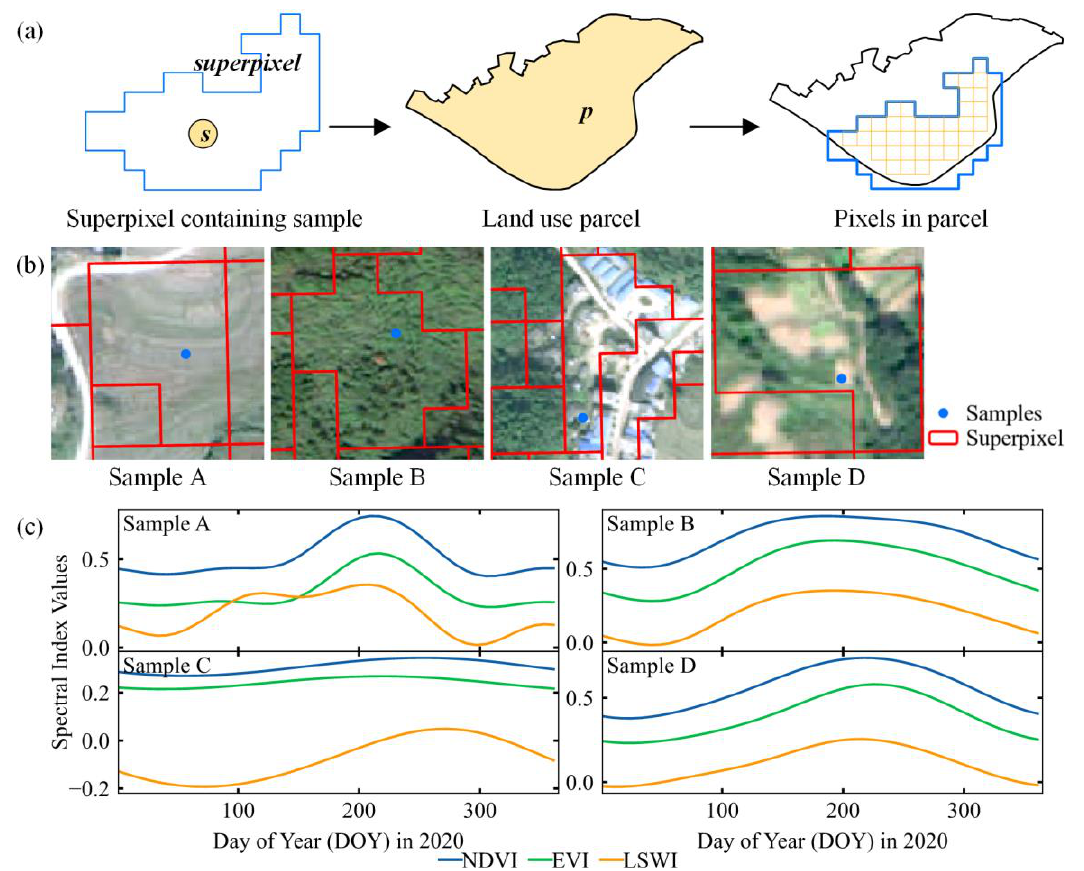
Figure 5. Superpixel segmentation map and superpixel-wise time series construction: ( a ) superpixel-wise sample data construction. ( b ) The high-resolution true-color image and superpixel segmentation at selected sample points with different land use types. Sample A (rice, longitude: 108.54357776°E, latitude: 27.37971958°N), Sample B (forest, longitude: 108.63321201°E, latitude: 27.27148616°N), Sample C (building, longitude: 108.72232946°E, latitude: 27.37451097°N), and Sample D (other cropland, longitude: 108.92616261°E, latitude: 27.45895508°N). ( c ) Superpixel-wise temporal profile of NDVI, EVI, and LSWI at four sample points in 2020.